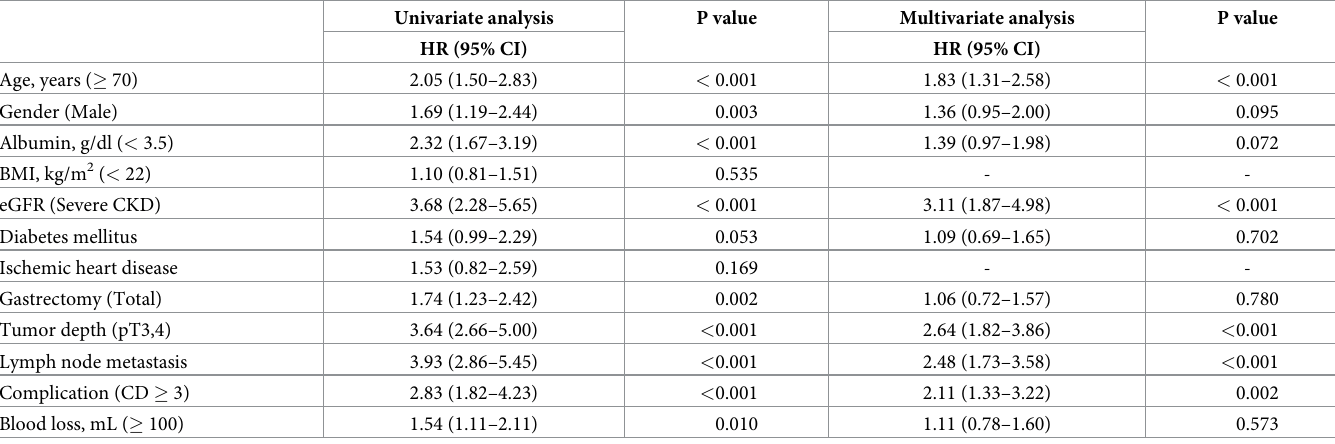
Table 4. Uni- and multivariate analyses of factors predicting overall survival